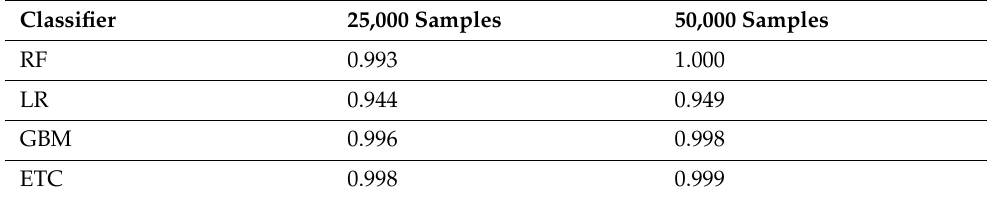
Table 6. Performance of machine learning models using all attributes.